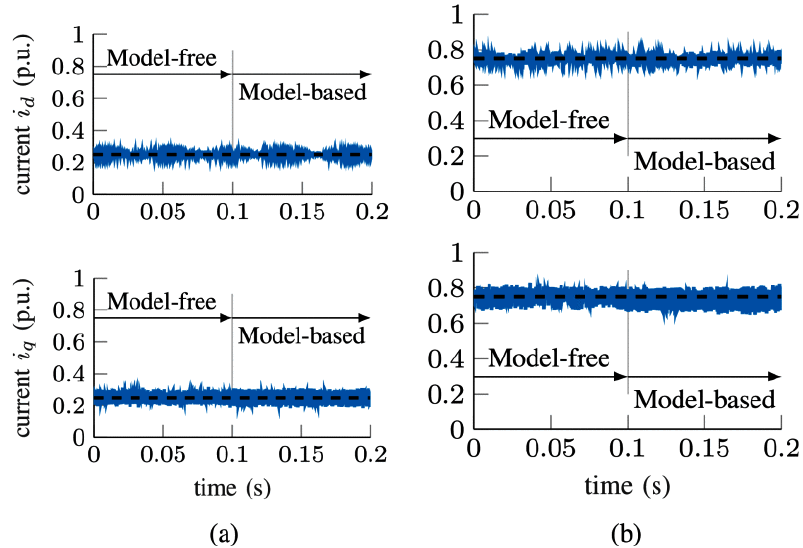
Figure 19. Comparison between model-based predictive control and model-free predictive control.